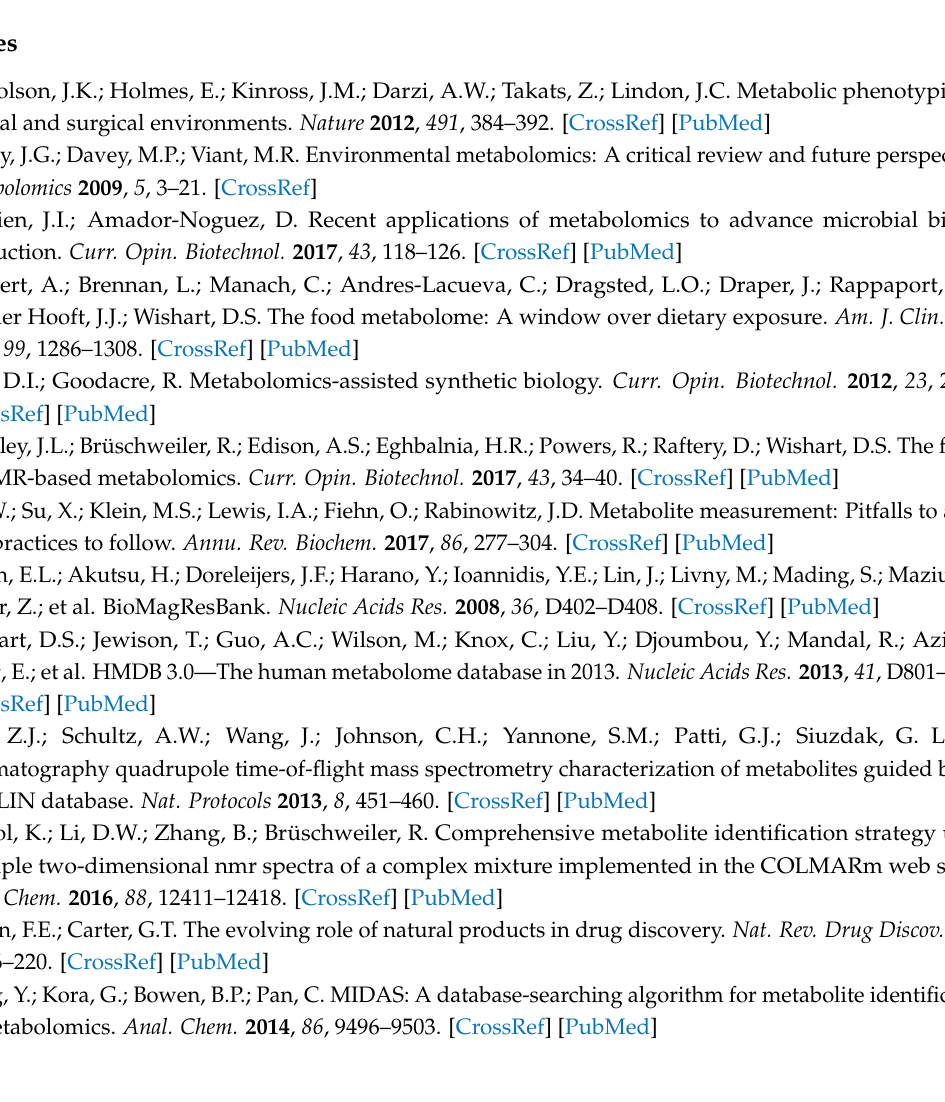
NMR spectra, Figure S3: total ion chromatogram of Arabidopsis metabolite extract, Figure S4: the MS/MS peak differentiating MS/MS prediction of glucoraphanin from the other isomers, Figures S5 and S6: overlay of the Table S1: the list of precursor ions that were selected for